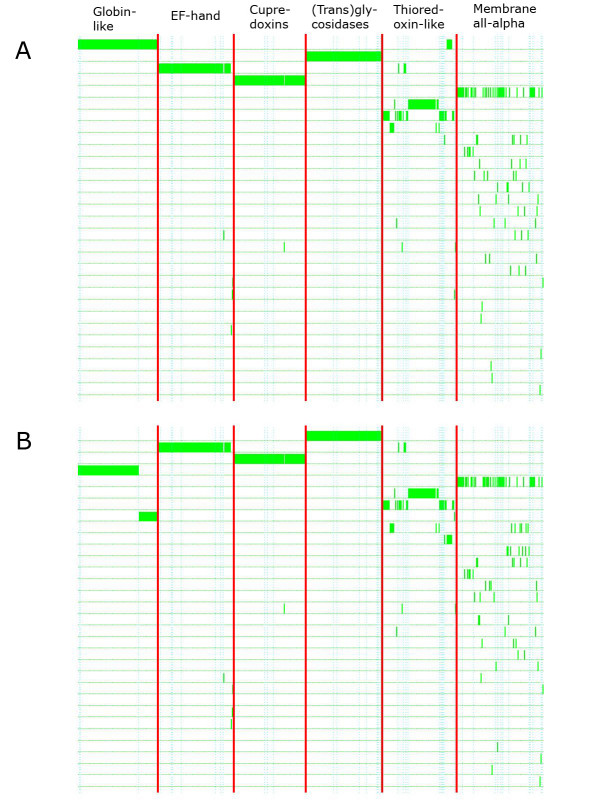
Graphical summary of the obtained clustering results of FORCE for the two similarity functions (A) BeH and (B) SoH, and dataset ASTRAL95_1_161. We used MATLAB scripts provided by Paccanaro to create images similar to those of Figure 3 in [7]. Each row corresponds to a cluster. Green bars represent a protein assignment to a cluster; each protein is present in only one of the clusters. Boundaries between superfamilies are shown by vertical red lines, and boundaries between families within each superfamily are shown by dotted blue lines.